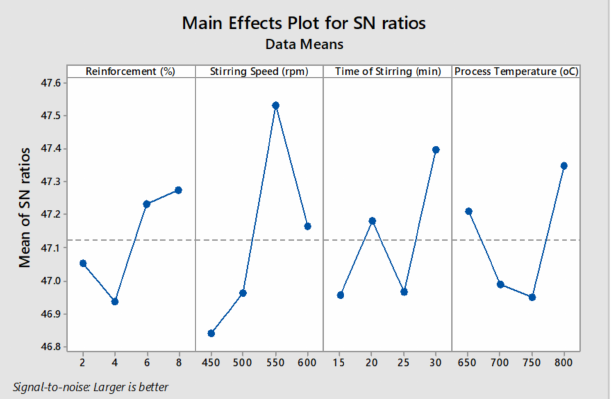
Figure 10. Main effect plot for SN ratios (tensile